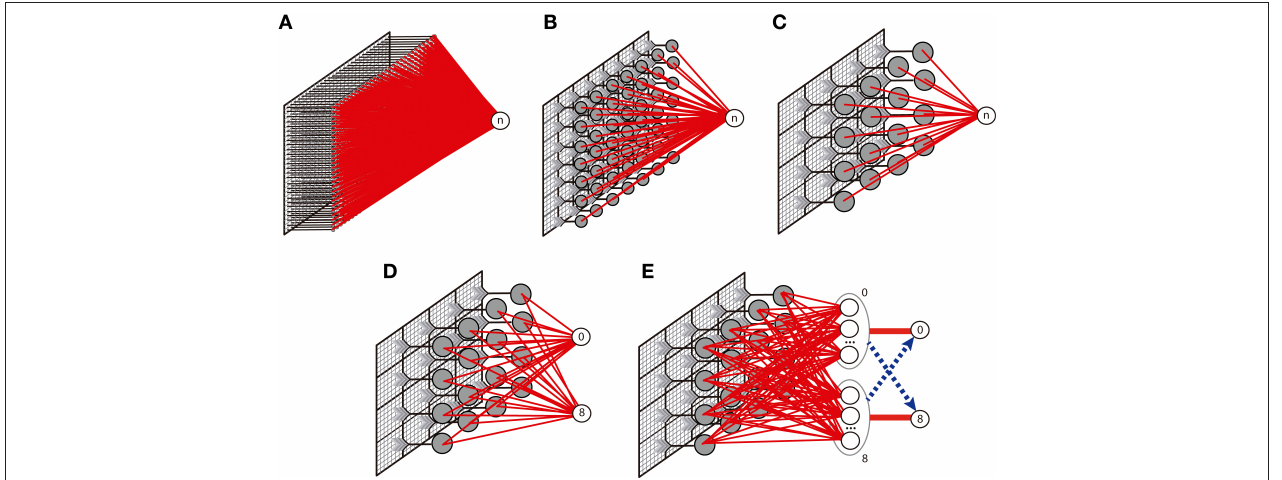
FIGURE 13 | Description of the different network topologies tested. In (A) , the nMNSD is fed with the original image (28 × 28 pixels); in (B) , the pixels are grouped in 49 (7 × 7) fields; in (C) , the pixels are grouped in 16 (4 × 4) fields. one-versus-one (OvO): (D) Original configuration and (E) enhanced version (with inhibitory bundles in blue).